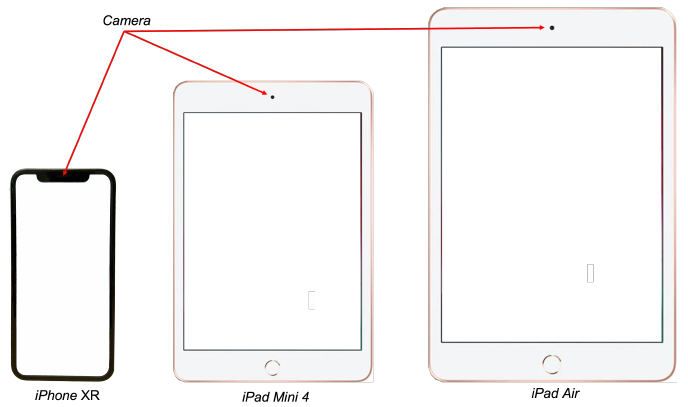
Figure 9. Camera location in the devices Apple iPhone XR , Apple iPad Mini 4 and Apple iPad Air